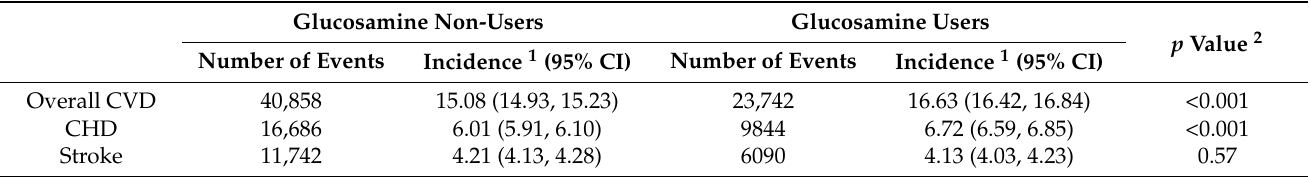
Table 2. Incidence of cardiovascular disease events.